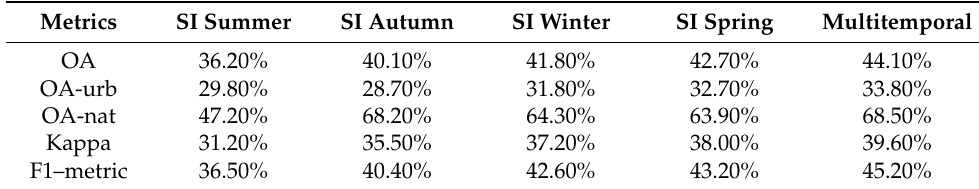
Table 2. Accuracy metrics for single image and multitemporal random forest classifications over Cape Town.